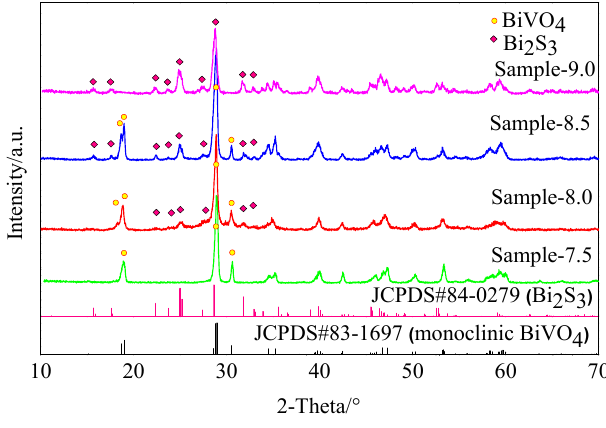
Figure 1. X-ray diffraction (XRD) patterns.